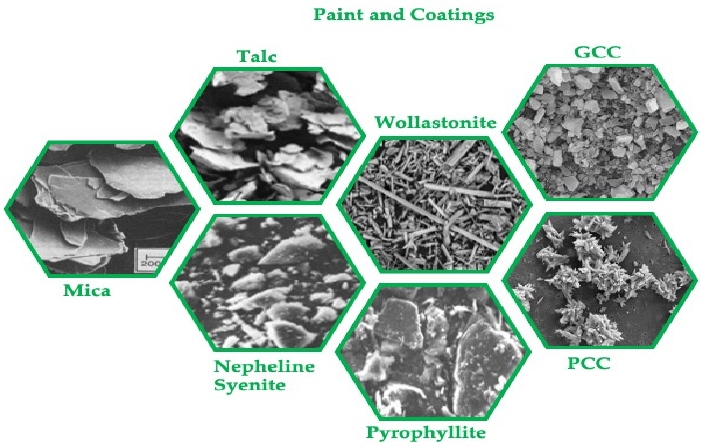
Figure 30. Effect of particle shape on paint and coatings (modified from [21]) .